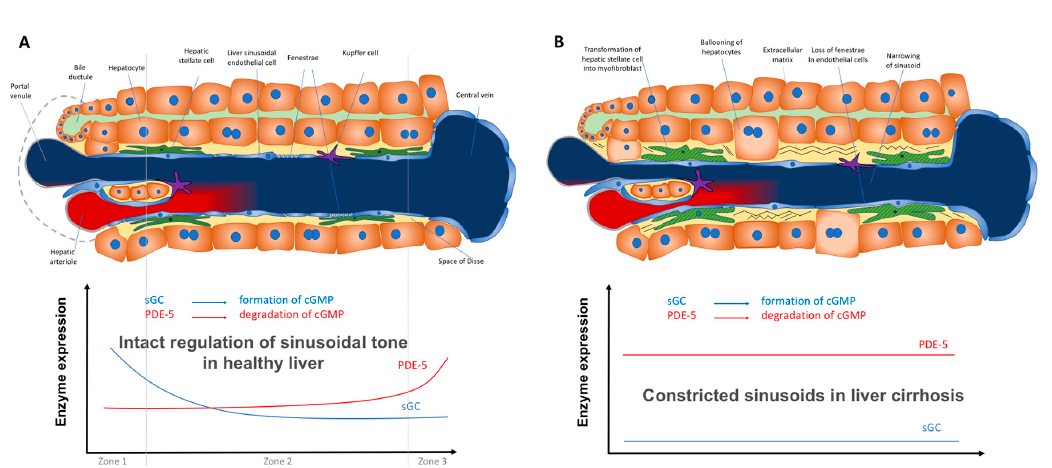
Figure 6. Regulation of sinusoidal tone by the key enzymes soluble guanylate (sGC) and PDE-5 in healthy and diseased liver. ( A ) In healthy livers an opposing zonation of sGC and PDE-5 may lead to a high cGMP production in the peripheral parts of the hepatic lobule, in which cGMP may exert its physiological function inside the sinusoids. However, excess cGMP might be degraded by high PDE-5 presence (zone 3) before entering the extrahepatic vasculature. ( B ) In cirrhotic livers the loss of physiological hepatic zonation, marked PDE-5 overexpression, and resulting increase in cGMP degradation might lead to sinusoidal constriction.